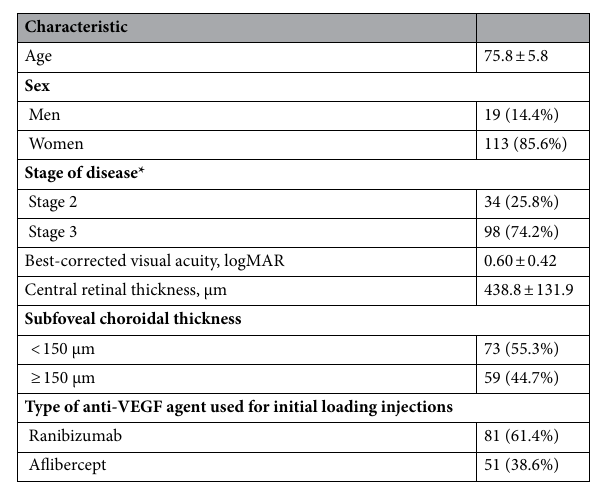
Table 1. Baseline characteristics of patients included in the study (n = 132). Data are presented as mean ± standard deviation or number (%), where applicable. logMAR logarithm of minimal angle of resolution; VEGF vascular endothelial growth factor. *Disease stage was classified based on the method proposed by Su et